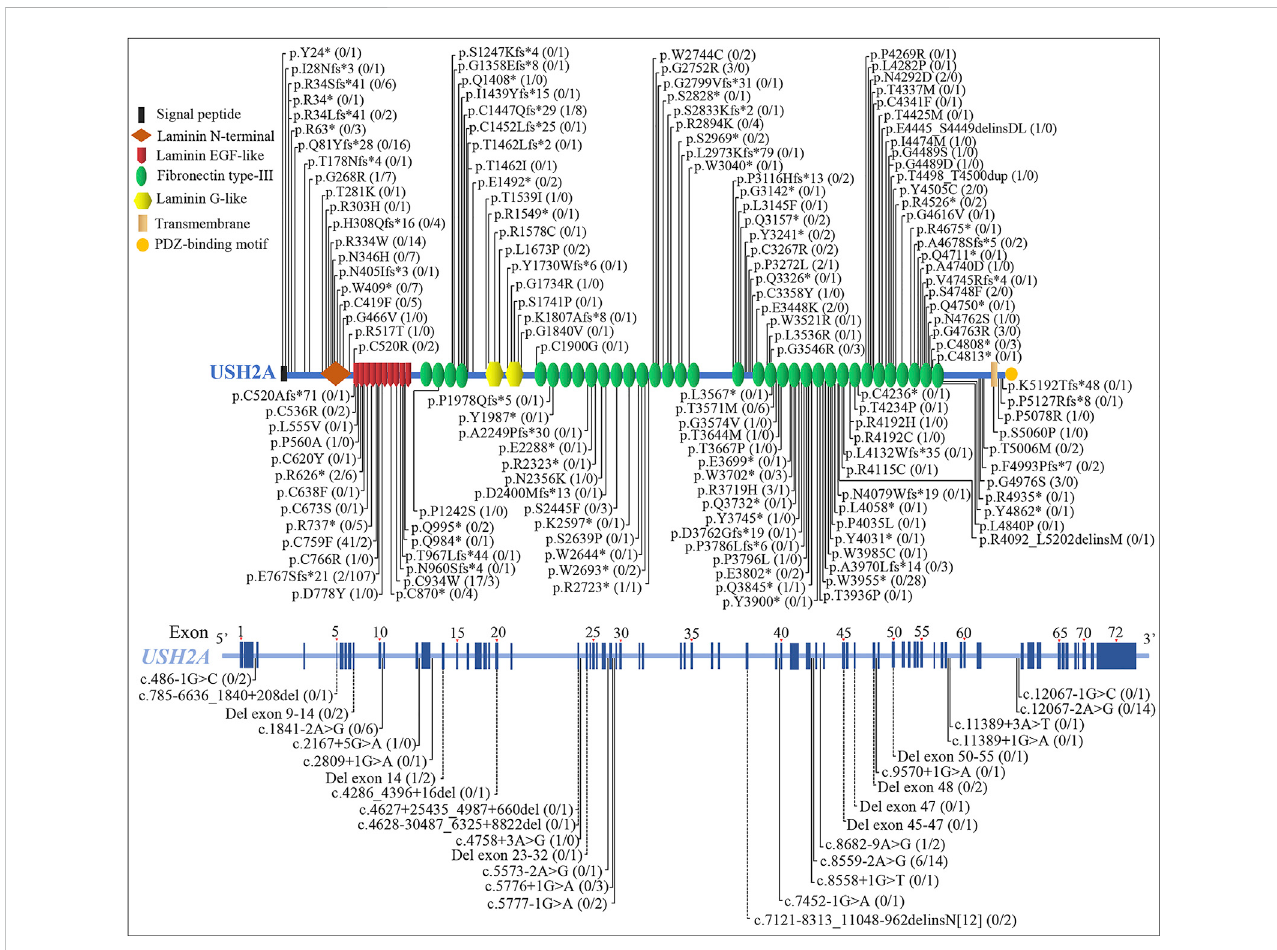
FIGURE 6 Schematic distribution of the usherin gene ( USH2A ) homozygous variants associated with retinitis pigmentosa (RP) and Usher syndrome type IIA (USH2A). Numbers in parentheses after the variants represent the number of patients with RP and USH2A, separated by the slash. The dotted line indicates deletion or deletion-insertion with changes over 20 bp. EGF, epidermal growth